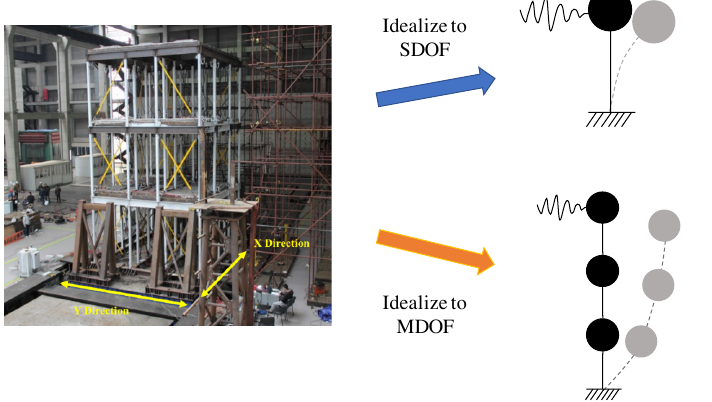
Figure 7. Structural idealization of the test steel